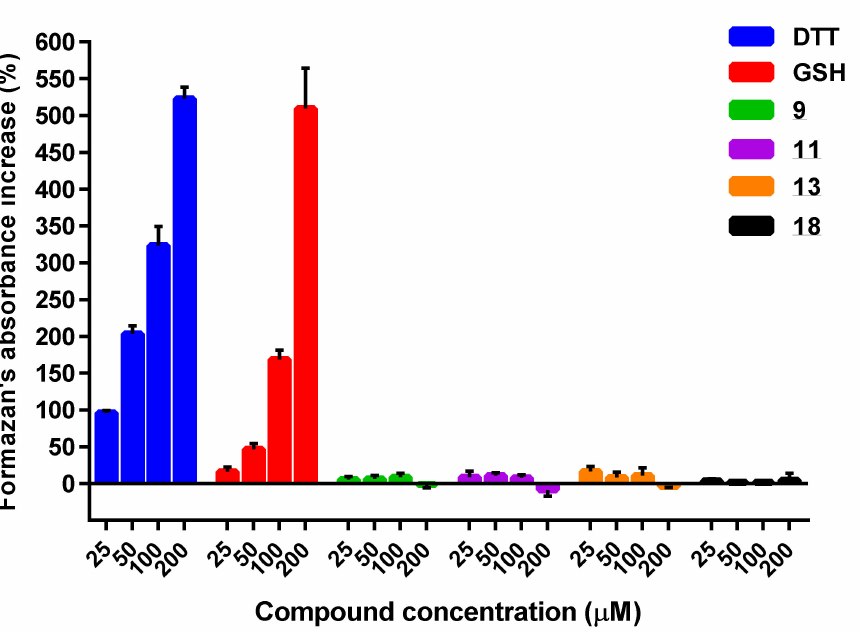
Figure 6. Reactivity study of dithiothreitol (DTT), glutathione (GSH), and compounds 9 , 11 , 13 , and 18 with MTT in DMEM: F12 medium (without cells, FBS, and phenol red) for 4 h at 37 ◦ C. Results represent the absorbance increase (%) at 570 nm. Values are the Mean ± SD of two experiments performed on different days and carried out in quadruplicate in 96-well culture